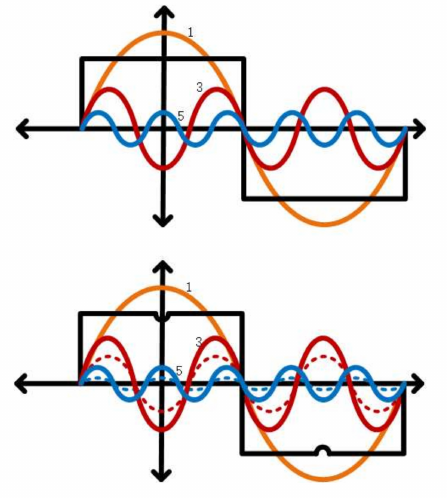
Figure 8. Schematic diagram of harmonic changes in magnetomotive force.